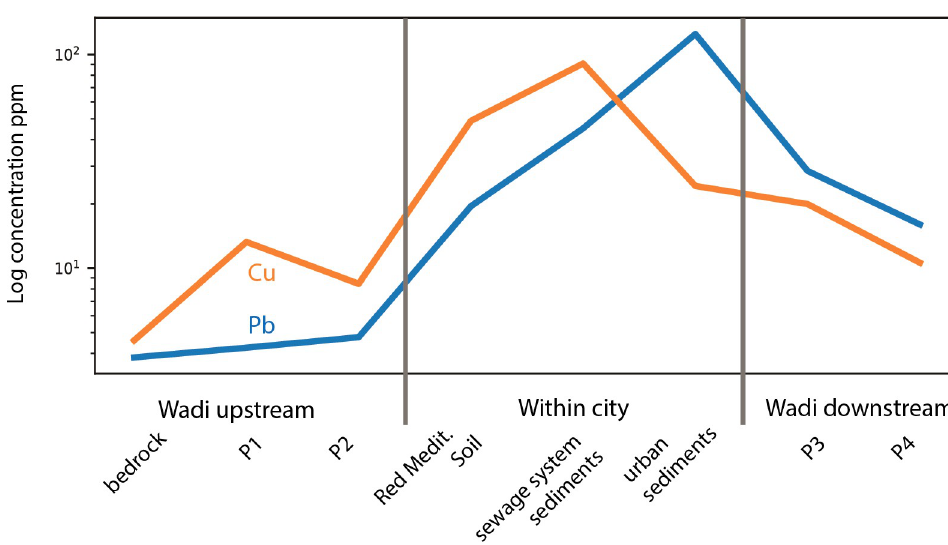
Fig 3. Variations of metal values of Cu and Pb in soils and sediments upstream, within the city and downstream of the ancient city of Jerash